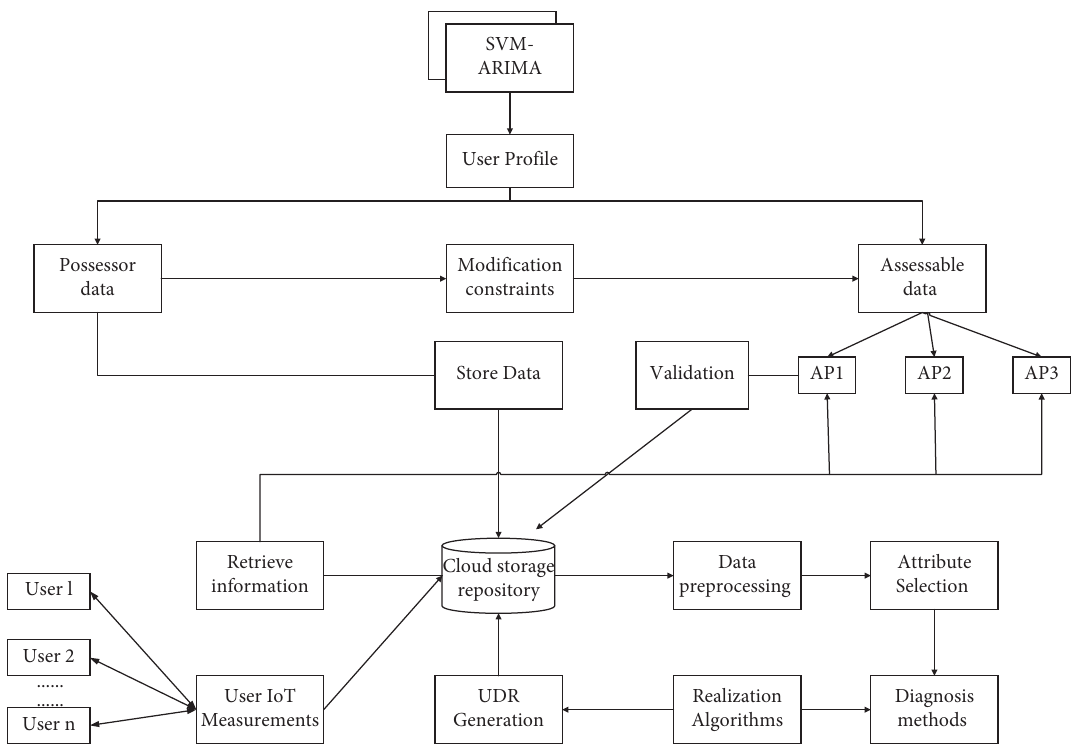
Figure 1: Support vector machine-based algorithm flow framework for granular